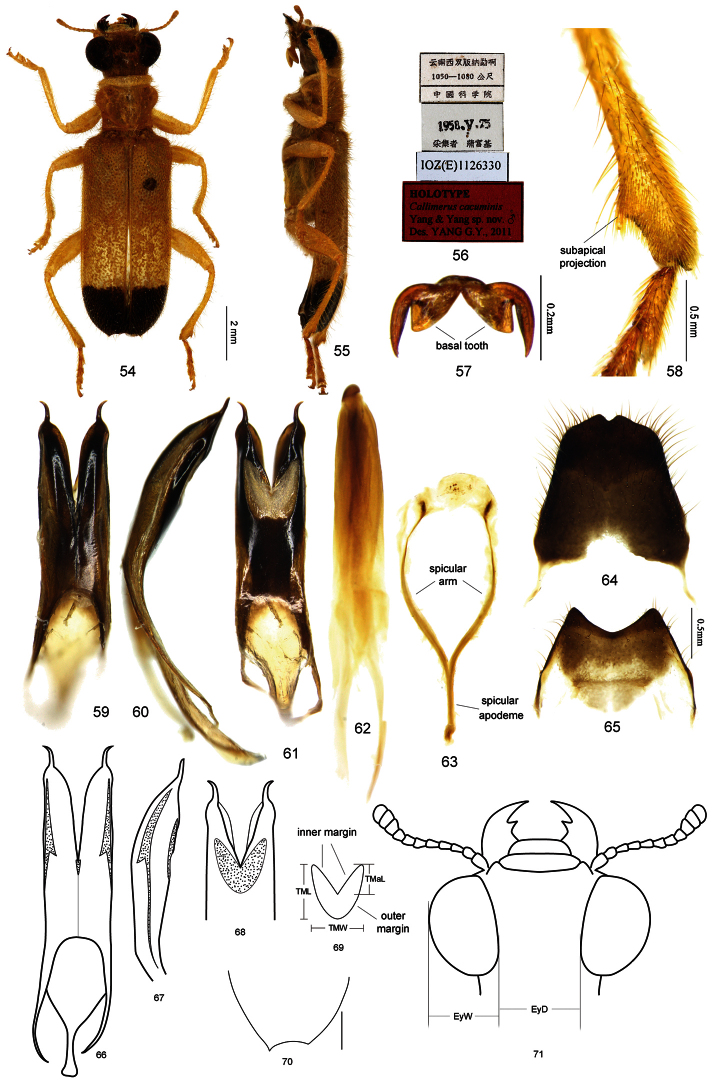
Holotypeof Callimerus cacuminis YANG & YANG. 54–55 habitus (54 dorsal view 55 ventral view) 56 labels 57 claw 58 subapical metatibia 59–61 tegmen (59 dorsal view 60 lateral view 61 ventral view) 62 phallus 63 spicular fork 64 tergite VIII 65 sternite VIII 66–69 tegmen (66 dorsal view 67 lateral view 68 ventral view 69 outline of ventral membranous region) 70 elytron apex 71 head.